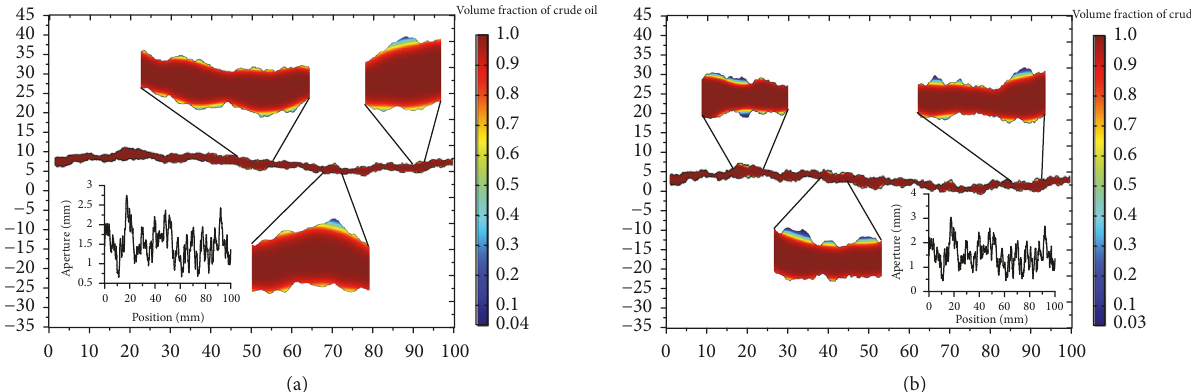
Figure 9: Distribution of aperture and restrict position of water while the crude oil is breaking through the fractures: (a) FD = 2.3 and 𝑃 𝑜 = 317.9 Pa; (b) FD = 2.4 and 𝑃 𝑜 = 317.9 Pa.